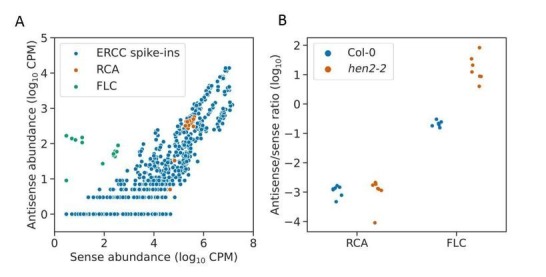
Antisense Illumina RNA-seq reads at RCA are likely to be spurious.(a) Scatter plot showing correlation of sense and antisense read abundances derived from Illumina RNAseq data mapping to ERCC spike-in controls, shown in blue. Each point represents a single spike in transcript detected in a single RNAseq replicate (both Col-0 and hen2-2). Since ERCC spike-ins should not have antisense RNAs, this indicates the level of spurious antisense signal in the dataset. RCA, shown in the orange, does not display antisense RNA levels greater than the ERCC spike-ins, indicating that there are not likely to be genuine antisense RNAs at this locus. FLC, which is known to have antisense RNAs, is shown in green as a positive control. (b) Strip plot showing the sense/antisense read ratio at RCA does not change in the hen2-2 mutant (T test p=0.88). Many genuine antisense RNAs, e.g. those at FLC, are unstable and are therefore upregulated in the hen2-2 mutant relative to sense transcripts.